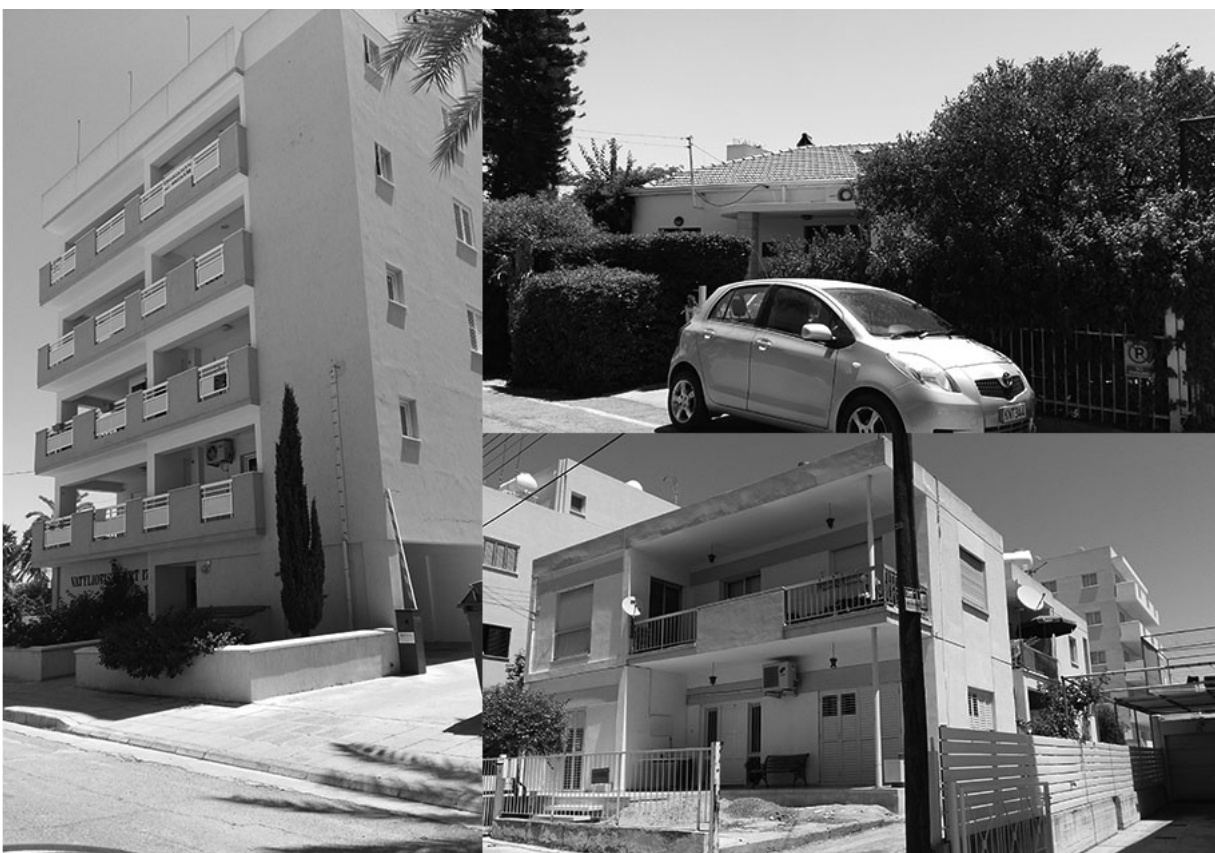
Figure 2. Suburban block images: Top right—prior to the 1970s; Bottom Right—1970s to early 1900s; Left—Mid-1990s until